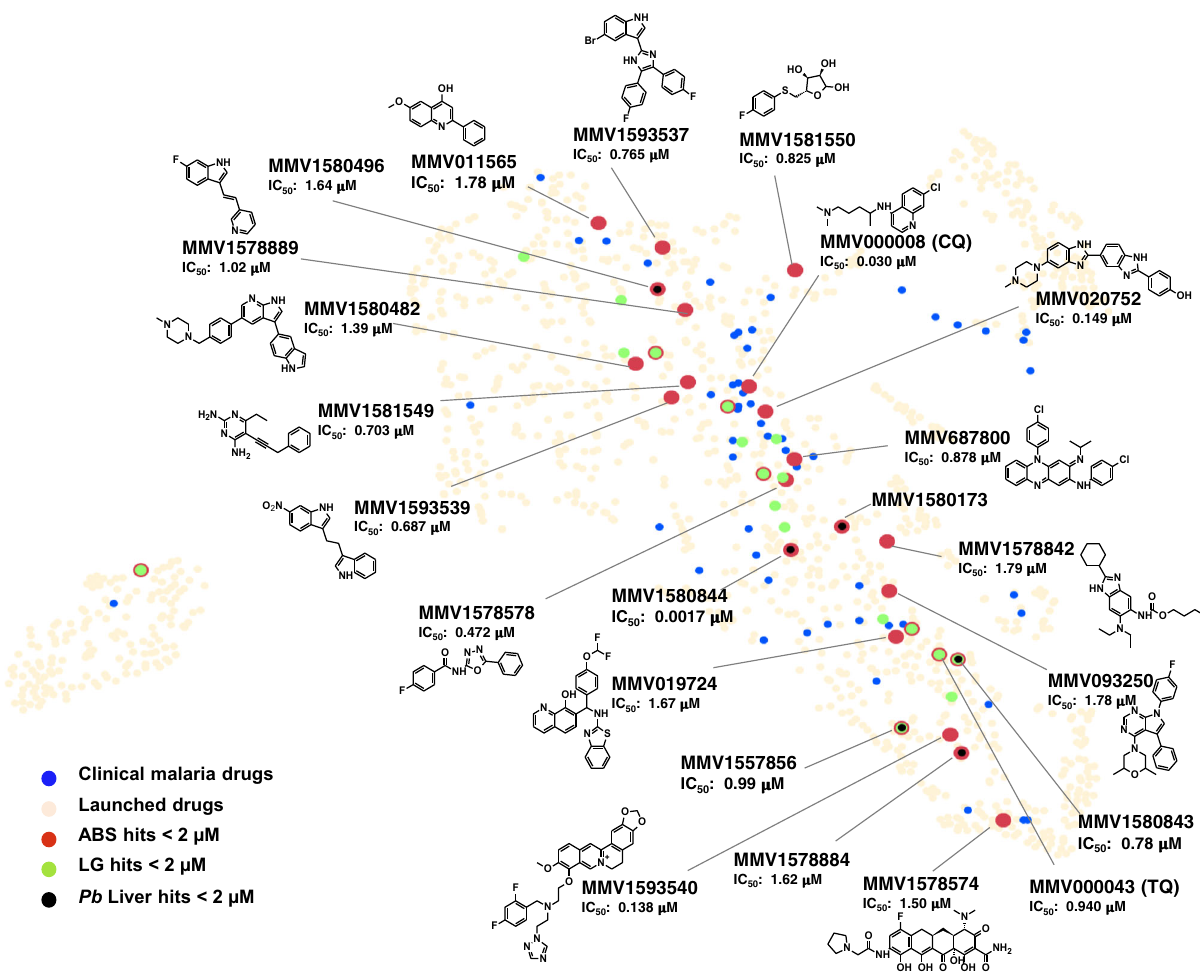
Fig. 4 Asexual blood stage active compounds from the PRB in relation to malaria clinical drugs. PRB compounds active against asexual blood stage (ABS) parasites of P. falciparum . Compounds with inhibitory concentrations (IC 50 ) <2 µ M were identi fi ed as hits against either Pf NF54 or Pf Dd2. PRB hits are represented in the launched drugs chemical space (available within the StarDrop V 6.6 software, beige) in comparison to malaria clinical drugs (blue dots). Asexual blood stage actives with IC 50 values <2 µ M are indicated in red, and gametocyte actives and liver stage actives (all at the same cut-off) are indicated in green and black, respectively, with different dot diameters to highlight compounds active on multiple stages. The 16 asexual-speci fi c compounds are labelled with Compound ID, asexual stage IC 50 and structure and other compounds of interest just by name and IC 50 . CQ chloroquine, TQ